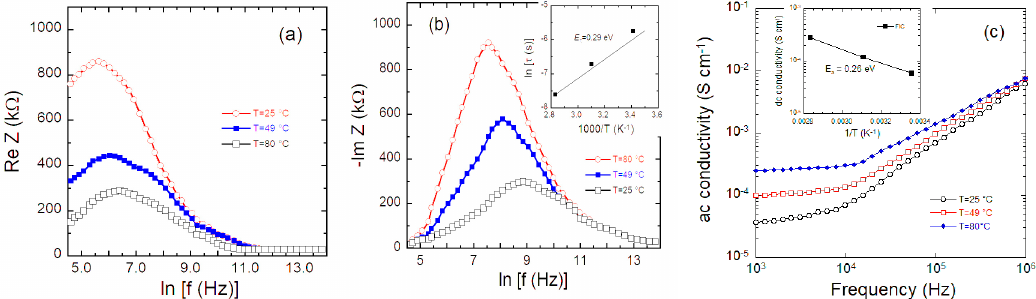
Figure 3. ( a ) Nyquist impedance plot of an idealized fast-ionic conductor (FIC). The semicircle centered at R b /2 represents the response of the R b , C b parallel element and straight line is the capacity of the electrolyte/electrode interface of impedance 1/ j ω C e . ( b ) Nyquist impedance plot of a FIC sample. The depressed semicircle reflects the combination of R b , C b , CPE 1 and the inclined straight Figure 4. ( a ) Plot of Re( Z ) vs. ln ( f ). ( b ) Plot of -Im( Z ) vs. ln ( f ) and (inset) determination of the line represents the double-layer capacity of the inhomogeneous electrode surfaces. activation energy E τ of the relaxation time. ( c ) Frequency dependence of the ac conductivity and (inset) determination of the activation energy E a of σ dc .